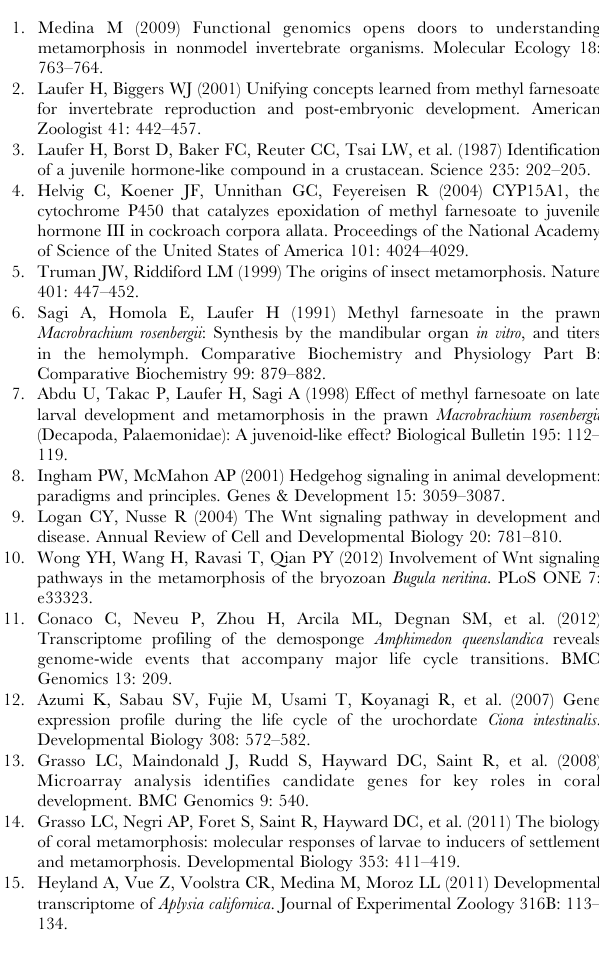
Figure S4 Bioinformatics characterization of four transcripts